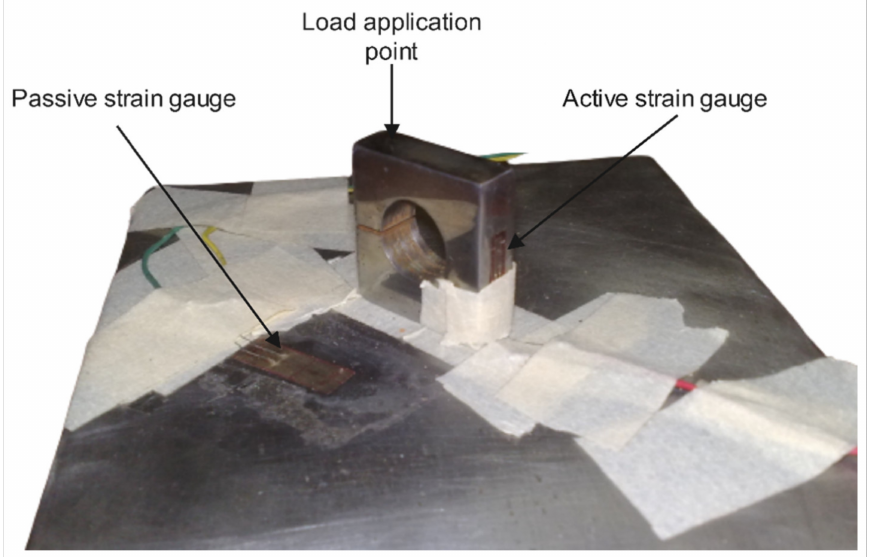
Figure 14. Load cell prototype.